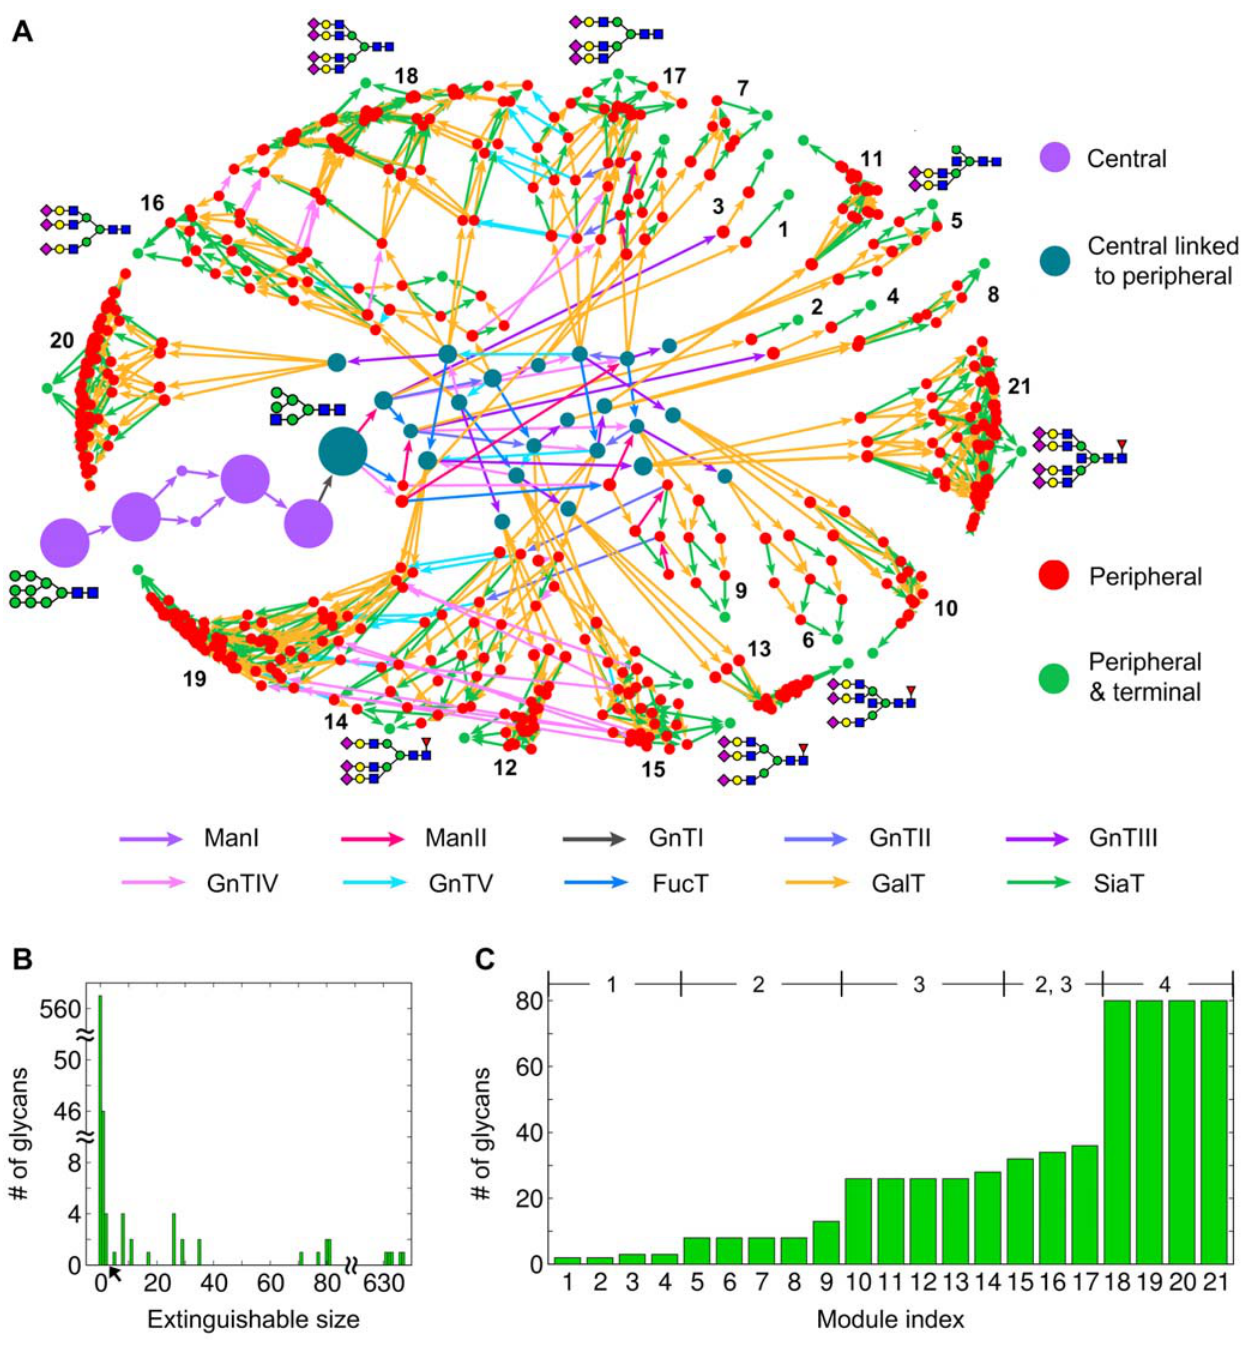
Figure 2. Modular organization of N -linked glycosylation pathways. (A) The global topology of the constructed N -linked glycosylation pathways. Circles stand for glycan species and arrows for enzymatic reactions from substrates to products. The size of each circle represents the impact on the pathways in the absence of the corresponding glycan. Circles and arrows are colored according to the positions in the pathways and the catalyzing enzymes, respectively. We depict the structures of some early and terminal glycans using the symbols in Figure 1. Glycan synthetic modules are labelled in the ascending order of the number of the participating glycans. (B) In the absence of each glycan, the number of extinguished downstream glycans is shown on the horizontal axis, and the vertical axis shows the number of such absent glycans leading to the same effect. The criterion of the central region is indicated by the arrow at the horizontal axis (Materials and Methods). (C) The number of glycans participating in each module. Module indices on the horizontal axis follow those appearing in (A). At the top in the horizontal direction, we show the number of GlcNAc on mannose branches that each terminal glycan has in a corresponding module.